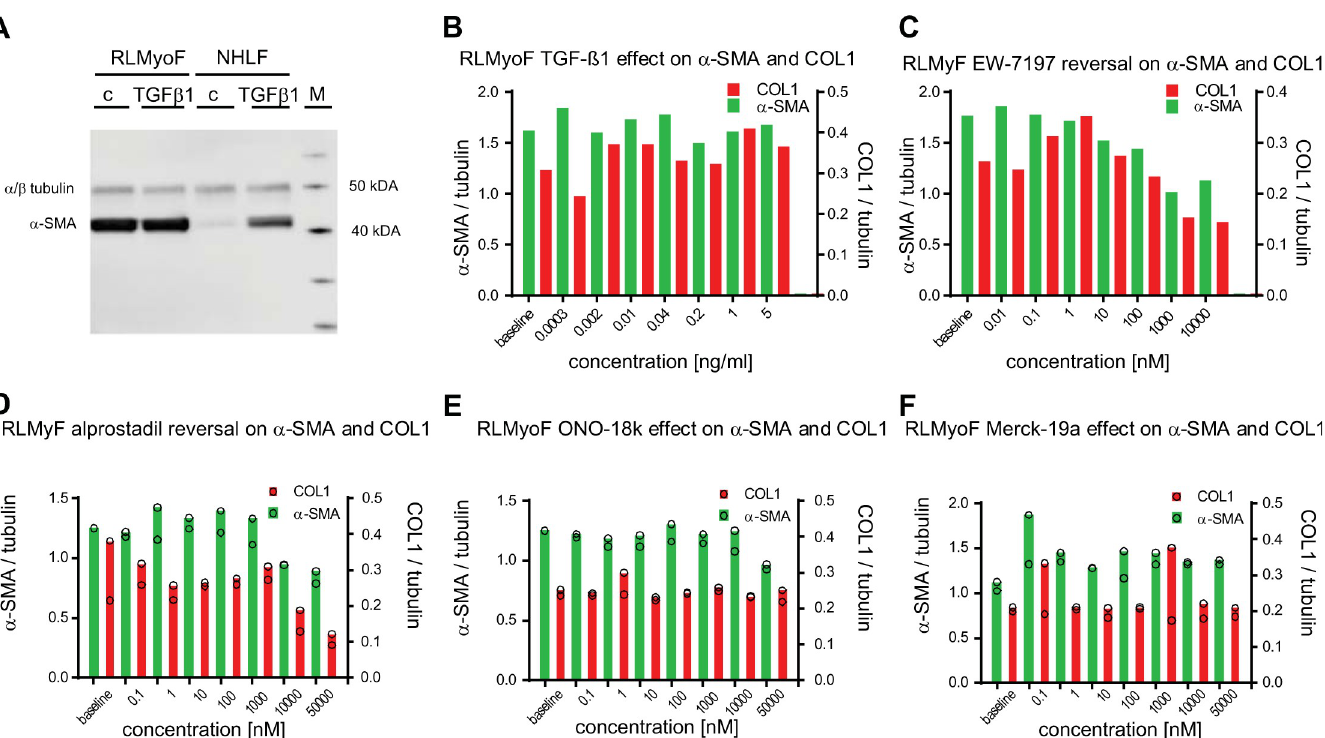
Fig 7. Effects on α –SMA and COL1 levels in primary myofibroblasts isolated from fibrotic lungs of bleomycin–instilled aged Wistar rats. (A) Primary NHLF and myofibroblasts isolated from fibrotic rat lung middle lobes (RLMyoF) 28 days after bleomycin instillation were serum starved for 24 h and stimulated either with 5 ng / ml TGF– β 1 (TGF– β ) or with the appropriate vehicle control (c) for 48 h. α –SMA (42 kDa) and α / β –tubulin (50 kDa) were quantified by immunoblot analysis. The protein molecular weight marker (M) was run in parallel to estimate protein size. (B) RLMyoF were starved for 24 h, stimulated with a dilution series of TGF– β 1 for 24 h, washed, cultured in the absence of TGF– β 1 for further 72 h, and lysed to quantify α –SMA, COL1 and tubulin from single wells by MS / MS detection. (C–F) Non– stimulated RLMyoF were starved for 24 h and then exposed to increasing concentrations of compound for further 72 h. Cells were lysed and α –SMA (green bars) and COL1 (red bars) were quantified by MS / MS to assess the effect of the ALK5 inhibitor EW–7197 (C), alprostadil (D), and the EP 2 and EP 4 receptor selective agonists ONO–18k (E), and Merck–19a (F), respectively. All analytes were normalized to tubulin. 0.1% DMSO solvent was present in all wells. Number of sample (n = 1) in (B, C) and (n = 2) in